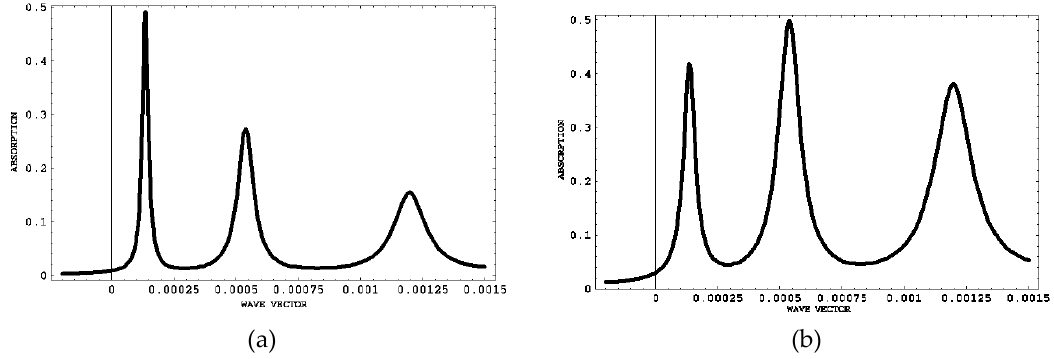
Figure 5. Absorption in the layer (1-R-T) for the π - π polarization case calculated versus the wave vector ( N = 700, δ 2 (cos 2 θ )/4 = 0.03) ( a ) for γ = 0.0002, ( b ) γ = 0.0007.